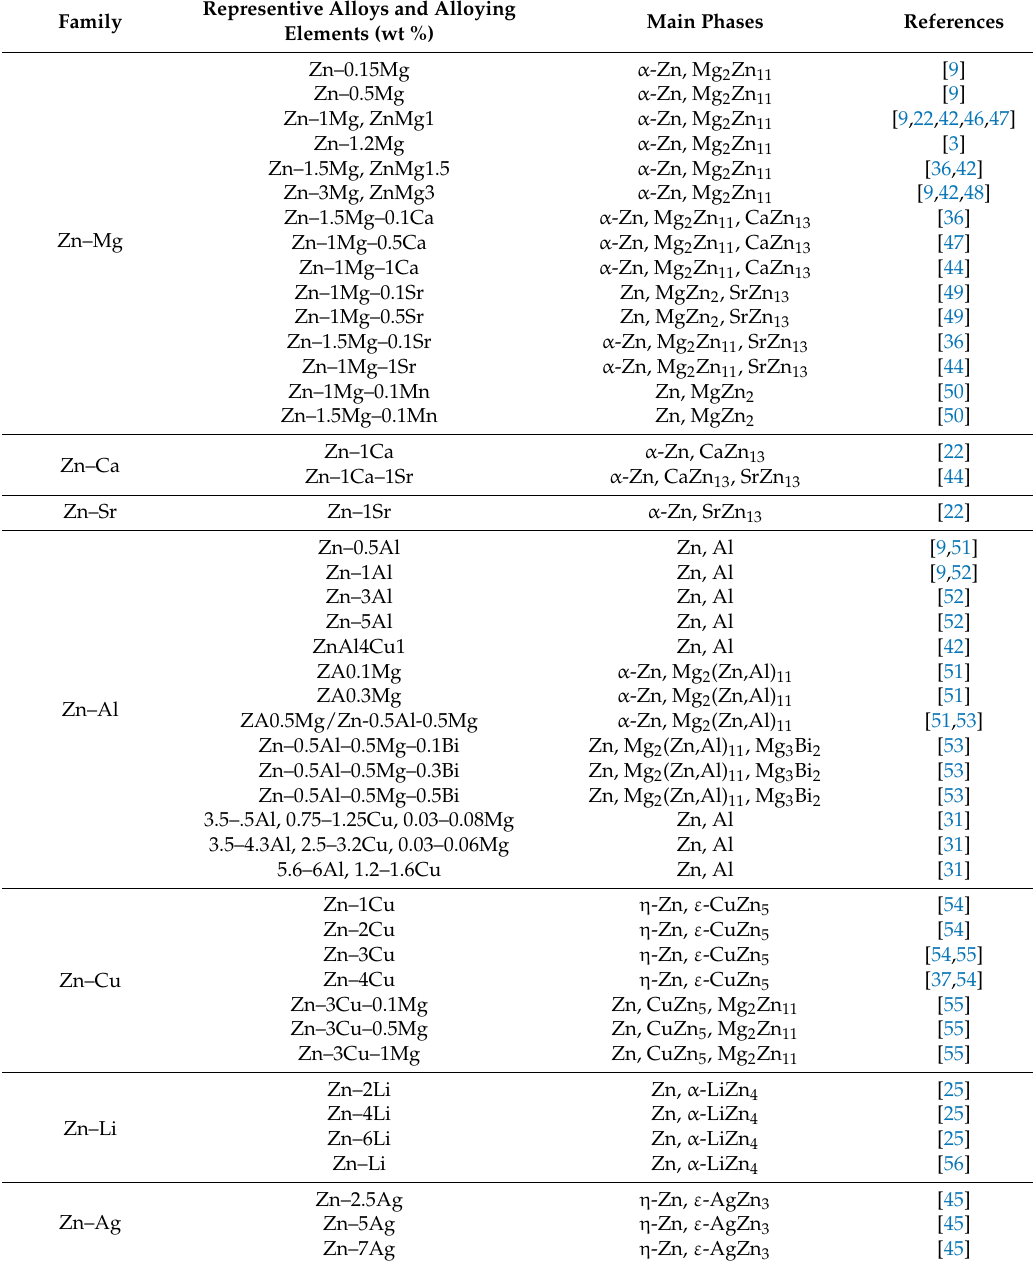
Table 1. Common biomedical zinc